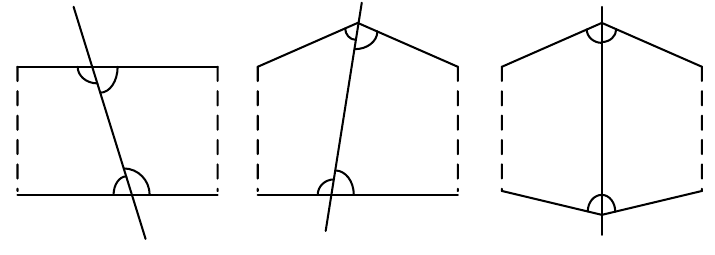
Figure 5. Three situations when dividing the